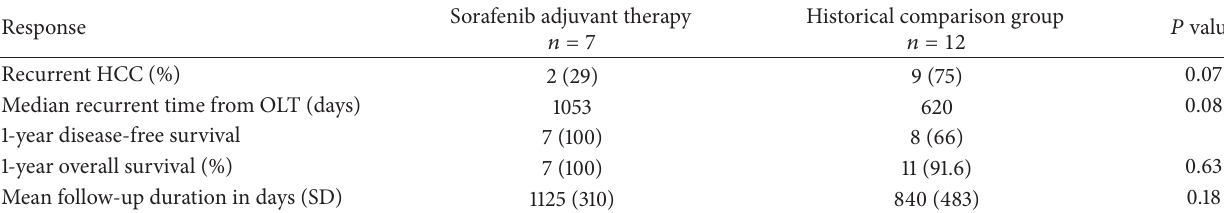
Table 3: HCC recurrence and survival